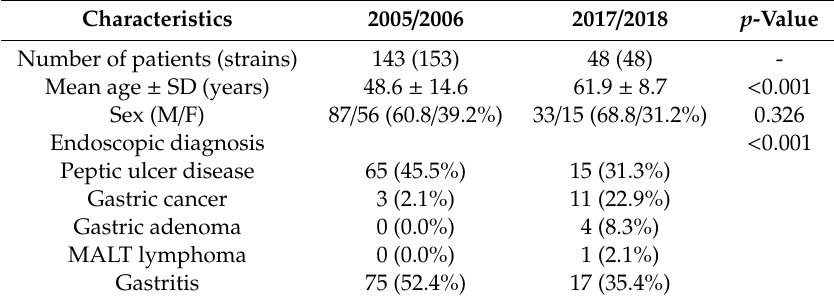
Table 1. The baseline characteristics of